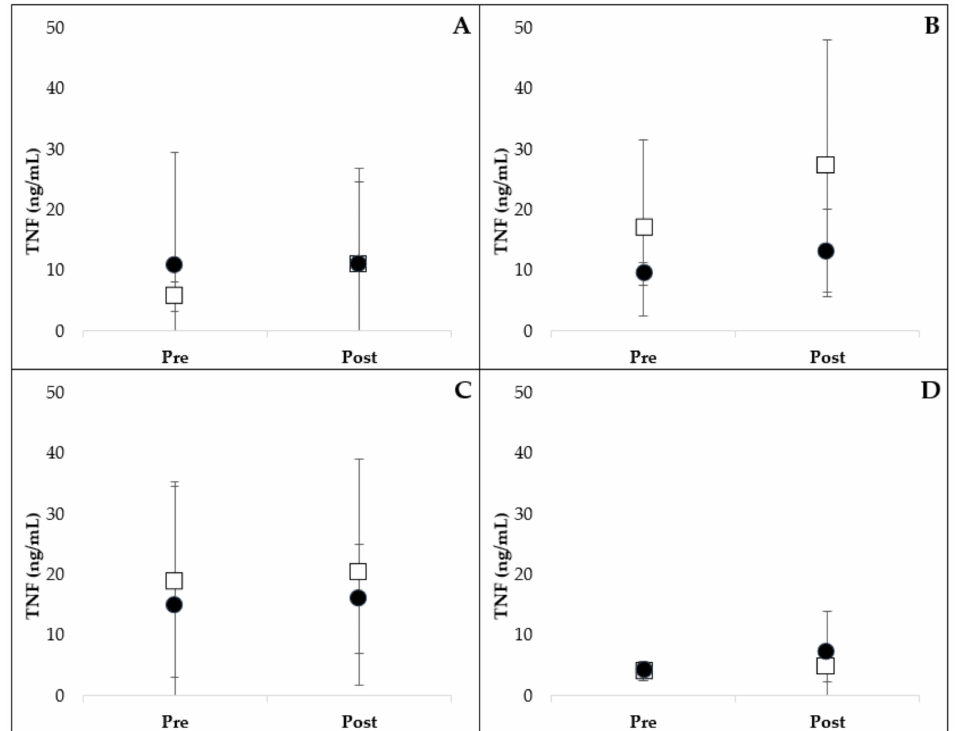
Figure 1. Leukocyte production of TNF following stimulation with LPS ( A ), LTA ( B ), PG ( C ) and control PBS ( D ). Pre- and post- 3-week oral administration of placebo (open square) or resveratrol (closed circle) supplement are represented. There was no significant di ff erence in TNF production between treatment groups over time (mean ± SD). LPS, lipopolysaccharide; LTA, lipoteichoic acid; PBS, phosphate-bu ff ered saline; PG,